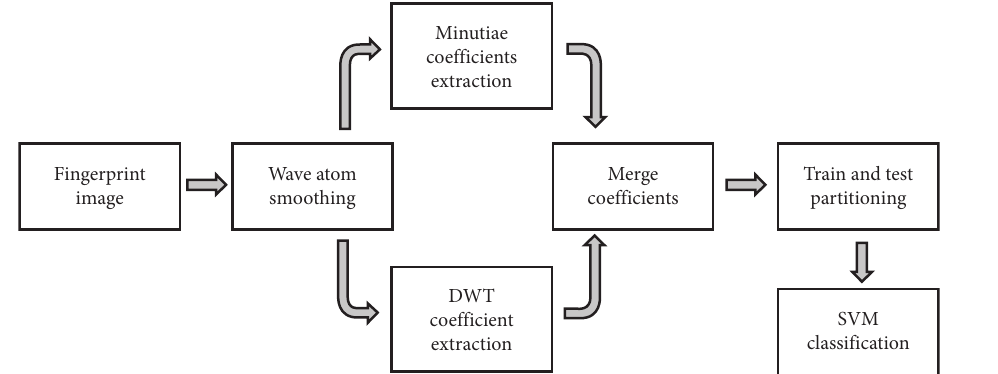
Figure 11: Design pipeline.